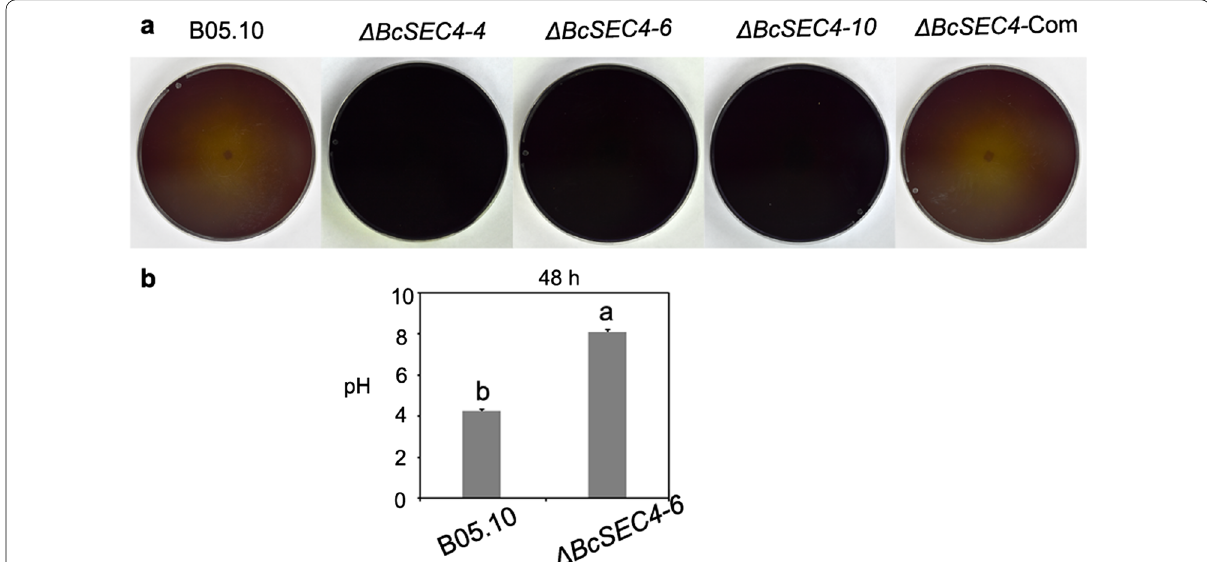
Fig. 3 BcSec4 is required for acidogenicity of B. cinerea . a Medium acidification by B05.10, the ΔBcSEC4 mutants, and the complemented strain. The tested strains were grown on solid complete medium supplemented with a pH indicator. The color change from purple to yellow indicates acidification (pH < 6.0). b PH value determined after incubated in YEPD liquid medium for 48 h. Data are represented as means deviations (SDs) from three independent experiments. Different letters indicate statistically significant differences ( P < 0.01)